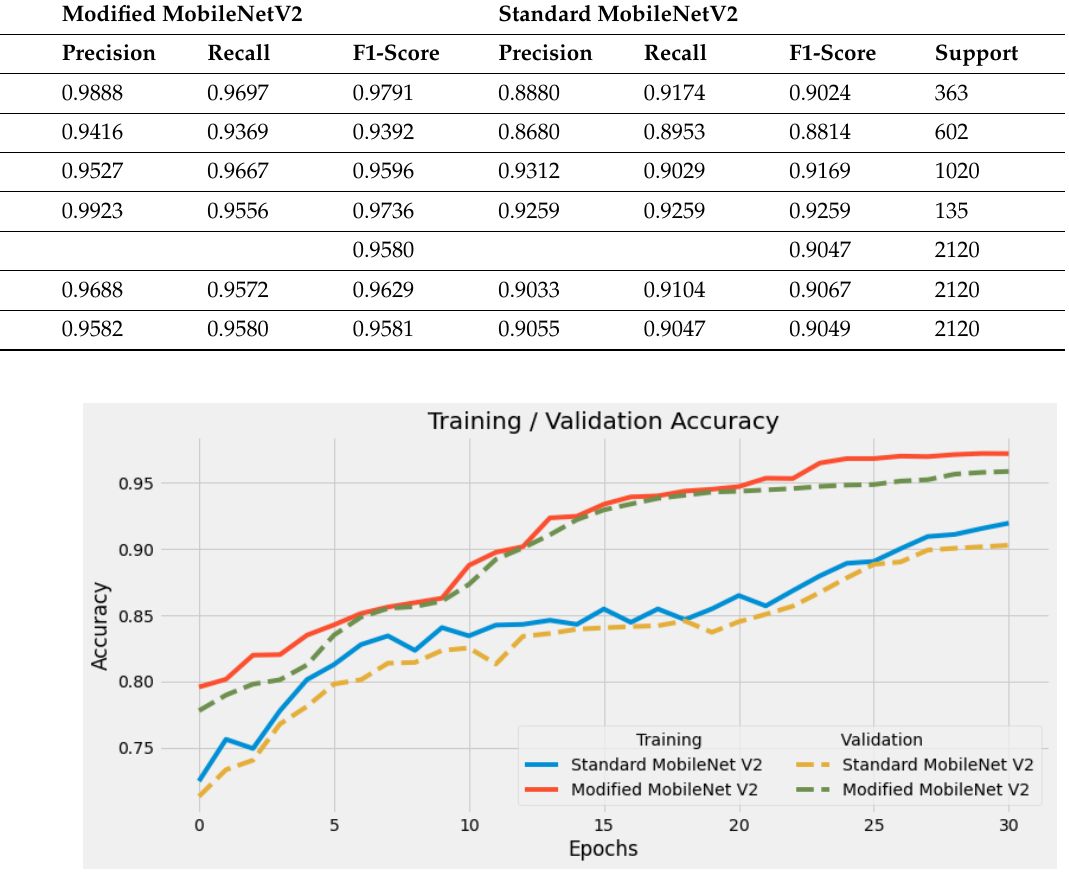
Figure 3. Comparison of training accuracy of standard MobileNetV2 and modified MobileNetV2. Our modified DL model presents a stable high accuracy due to its minimum loss per epoch.